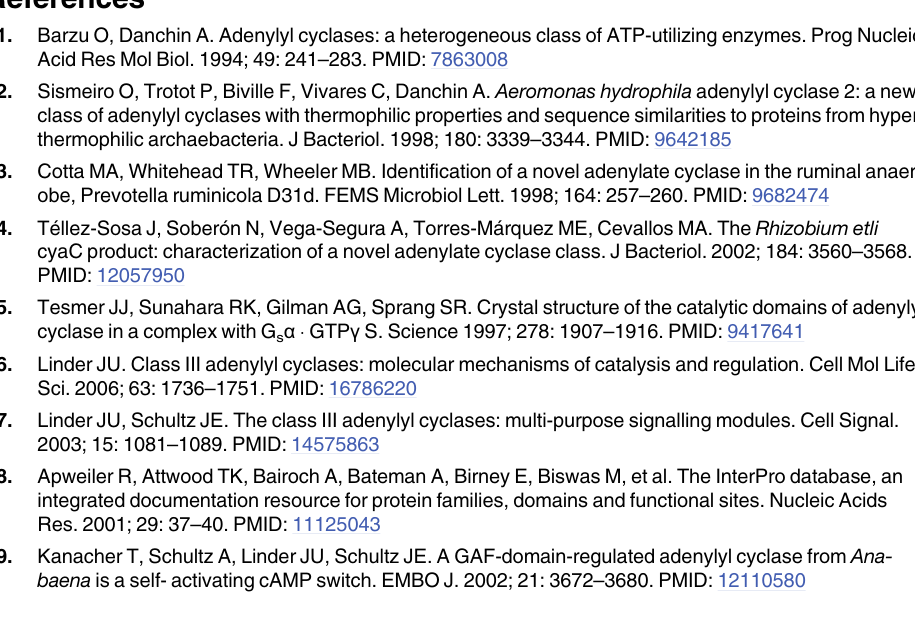
S1 Fig. Sequence of the synthetic gene for Mycobacterium phlei AC. Flanking Bam HI and Hind III are shown in italics. Differences to the natural gene (GenBank EID14989.1) are under- lined. (TIF) S2 Fig. Alignment of ACs carrying a C-terminal YHS-domain. In the CHD, critical func- tional residues for metal-cofactor binding (M), adenine-moiety binding (A) and for catalysis (C) are shaded black, as well as the four conserved putative transition-metal ion binding resi- dues of the YHS-domain. Sequences are from Mycobacterium phlei (GenBank EID14989.1), Mycobacterium marinum (GenBank ACC39874.1), Williamsia sp.ARP1 (NCBI reference WP_045825068.1); Candidatus Microthrix parvicella RN1; (GenBank CCM65060.1); Rhizo- bium leguminosarum (GenBank KEC71354.1); Rhizobium etli (NCBI reference WP_040141435.1); Fulvivirga imtechensis (GenBank ELR73472.1).